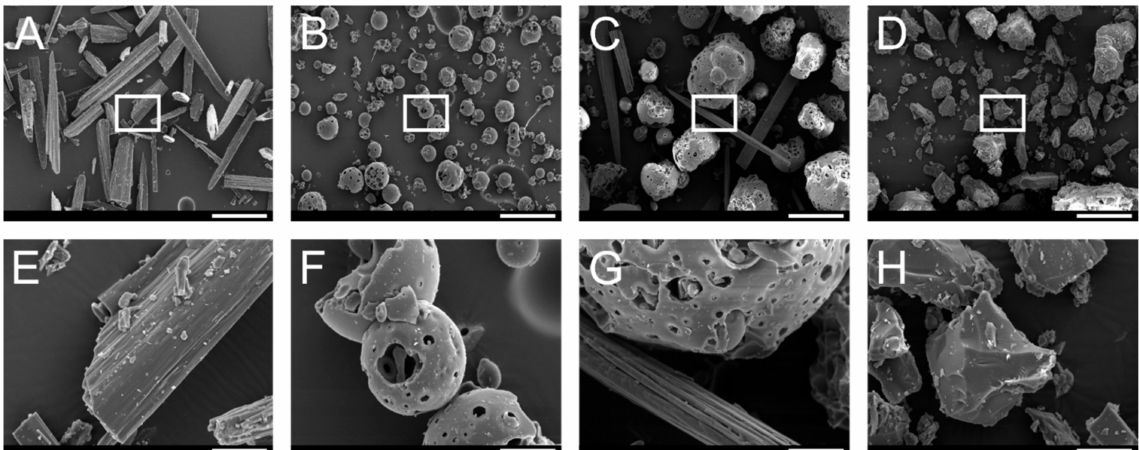
Figure 6. SEM micrographs recorded at an acceleration voltage of 10 kV of ( A ) PTN, ( B ) HP- β -CD, ( C ) physical mixture (1:1 molar ratio of PTN and HP- β -CD), and ( D ) PTN/HP- β -CD complexes with the respective magnification ( E – H ) corresponding to the white rectangle. Scale bars represent 200 µ m in ( A – D ) and 30 µ m in ( E – H ).